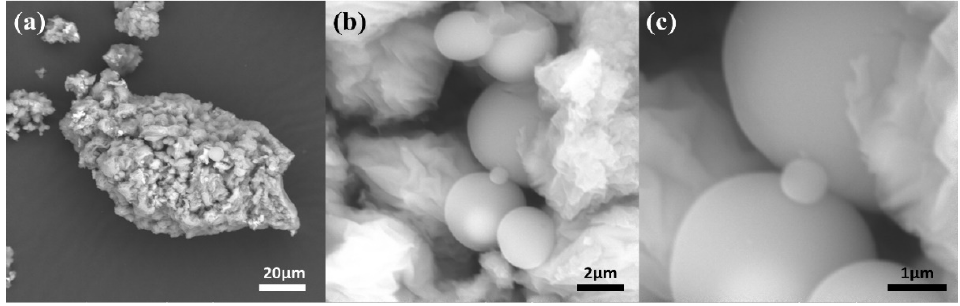
Figure 2. SEM micrographs of micro-spherical V 2 O 5 photocatalyst at ( a ) low, ( b ) medium and ( c ) high resolution. ( c ) high